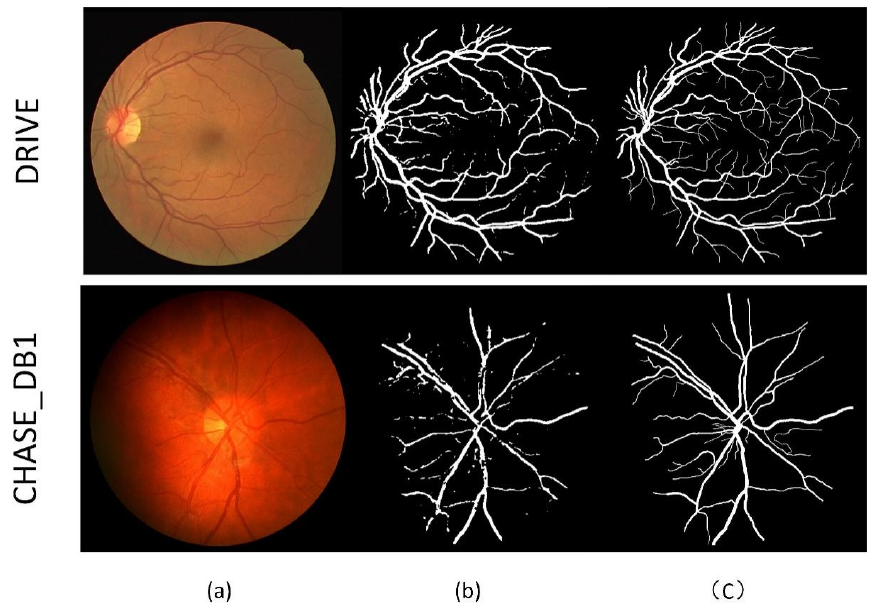
Figure 8. Retinal vessel segmentation sample image. ( a ) is the original images. ( b ) is the segmentation prediction maps of the proposed model, and ( c ) is the ground truth.